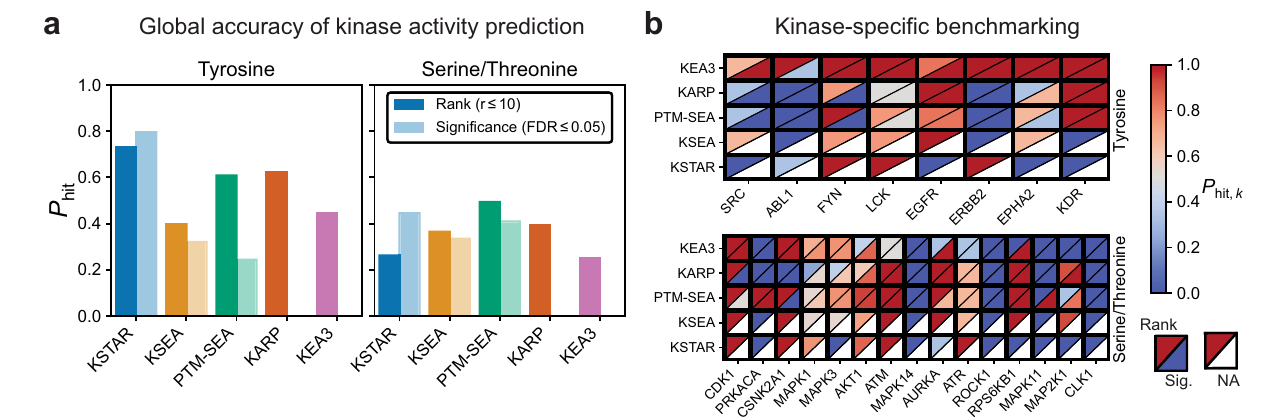
Fig. 3 | Comparing accuracy of KSTAR to other available kinase activity algo- rithms. KSTAR and four other publicly available kinase activity algorithms (KSEA, PTM-SEA, KARP, KEA3) were applied to a suite of inhibition and stimulation data- sets. Accuracy measures expected activity changes as de fi ned by P hit — the fraction of conditions for which a perturbed kinase was found differentially active, either basedonactivityrank(inthetop10kinases)orsigni fi cance(FDR<=0.05),whichis not available (NA) for KARP and KEA3. a Global accuracy of each algorithm for